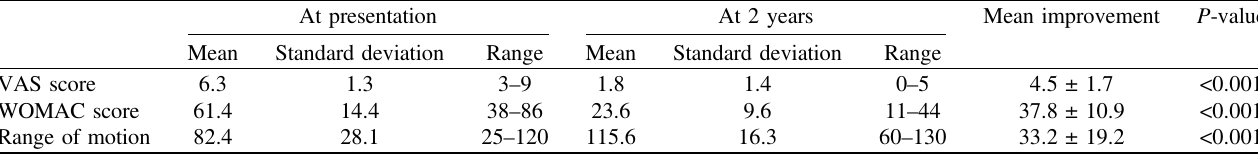
Table 4. Analysis of VAS, WOMAC, and range of motion of all patients.